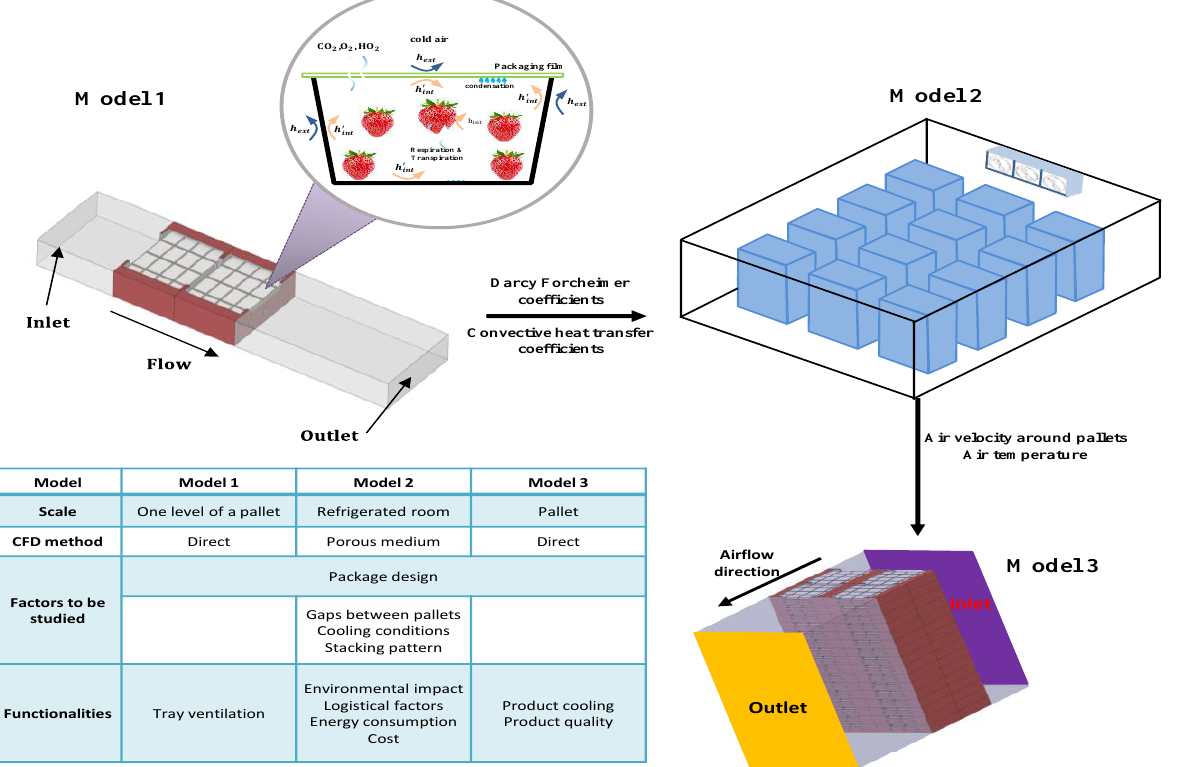
Figure 10. Schematic example of the multi-scale modeling approach .